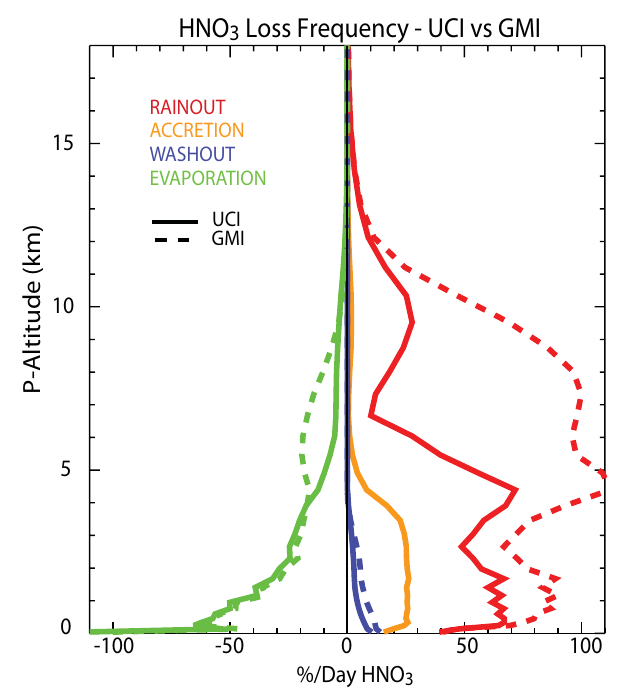
Fig. 1. Profile of globally-averaged HNO 3 loss frequency (%day − 1 ) for removal by each scavenging process: rainout (red), accretion (orange), washout (blue), and release via evaporation (green). UCI simulation is shown with solid lines, GMI simulation with dashed